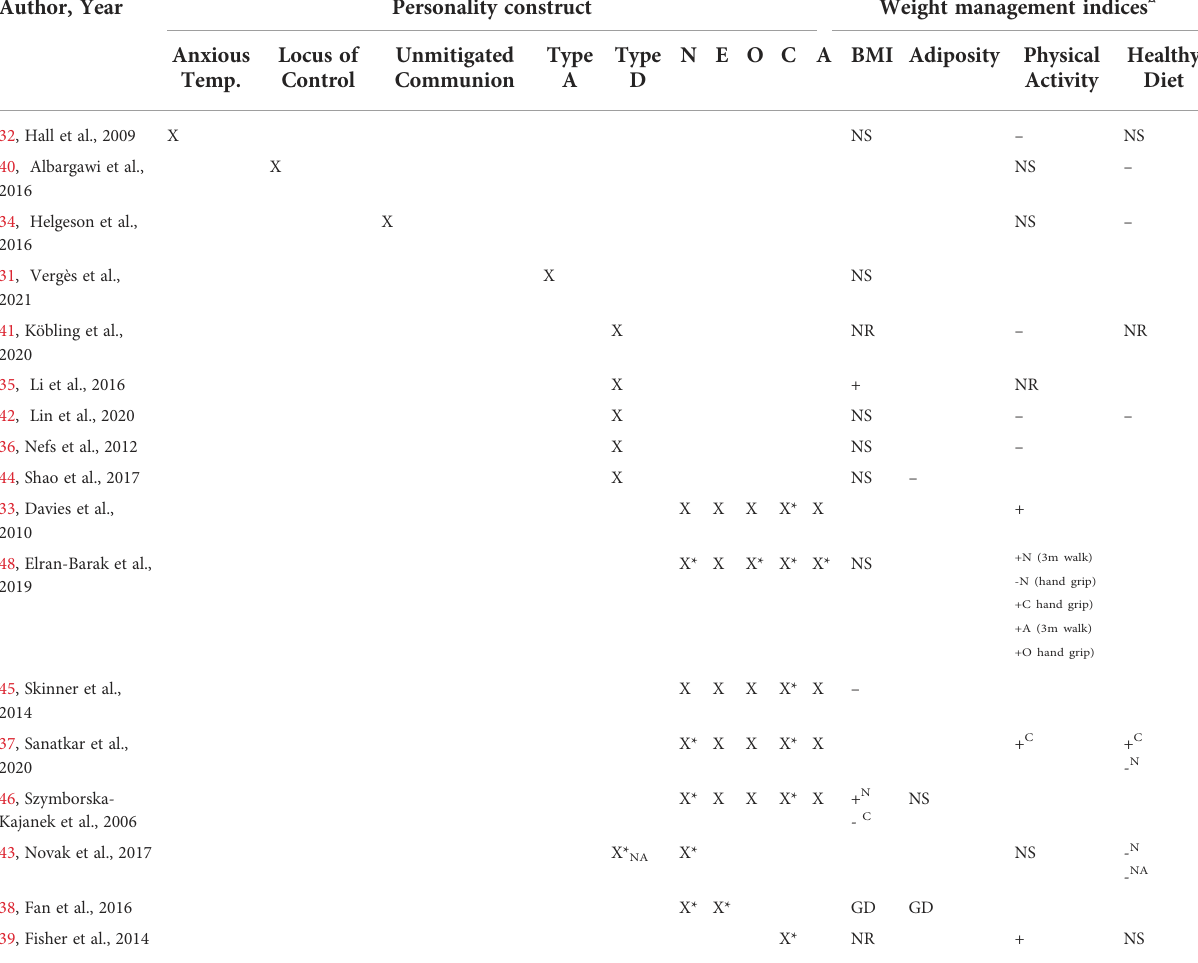
TABLE 3 Summary of the assessment of personality and the signi fi cance and direction of associations with weight management indices. Author,